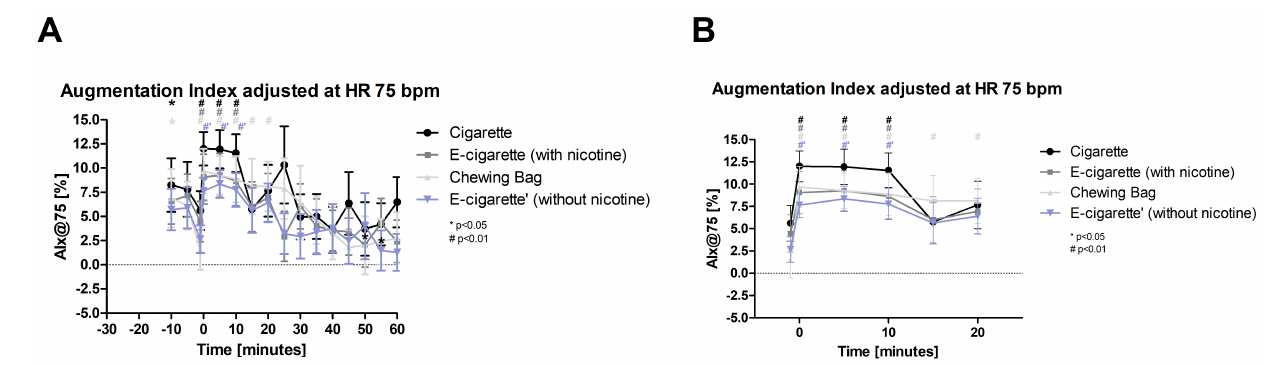
Figure 7. Augmentation index adjusted at HR 75 bpm ( A ) total follow-up; ( B ) follow-up of expected nicotine half-life). These figures display the Alx@75 over the time of the testing period. At the intervention (time 0), the four test groups show an immediate highly significant increase (# p < 0.01) which lasts until 10 min after the intervention.